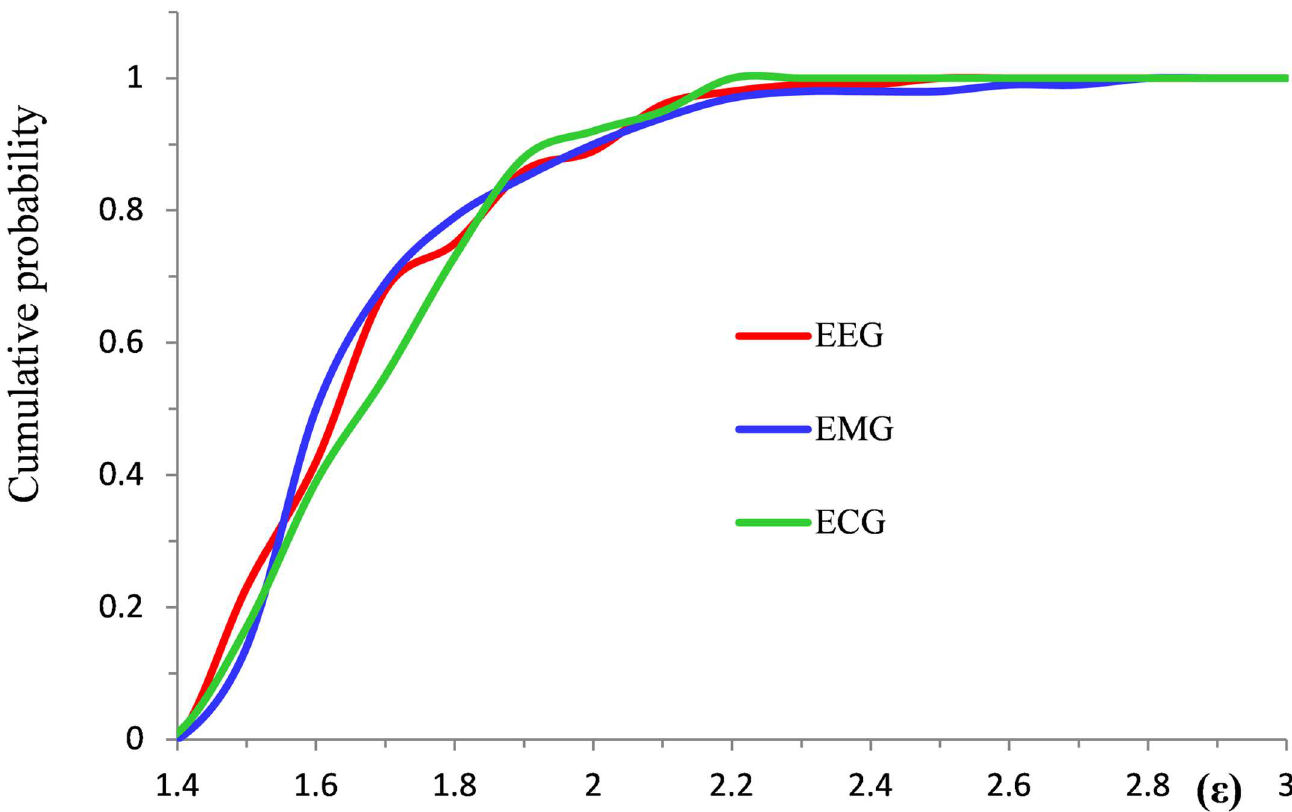
Fig 4. Kolmogorov-Smirnov statistical test applications for typical EEG, eye-blink EMG, and ECG data. Red, blue, and green lines are empirical cumulative distribution